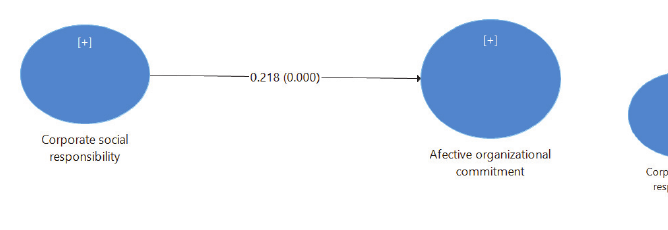
T Statistics P Values (|O/STDEV|)